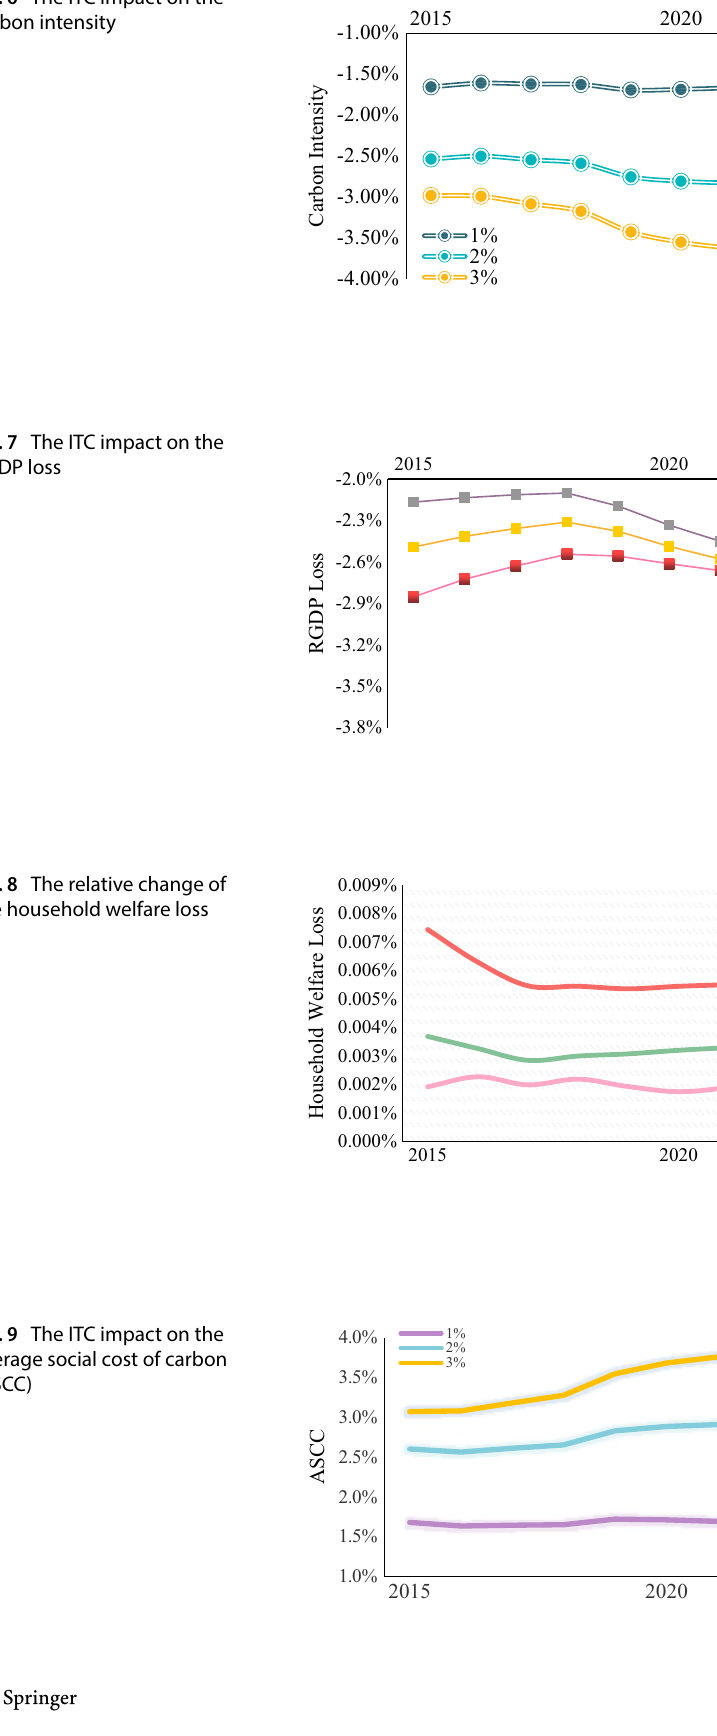
Fig. 6 The ITC impact on the carbon intensity